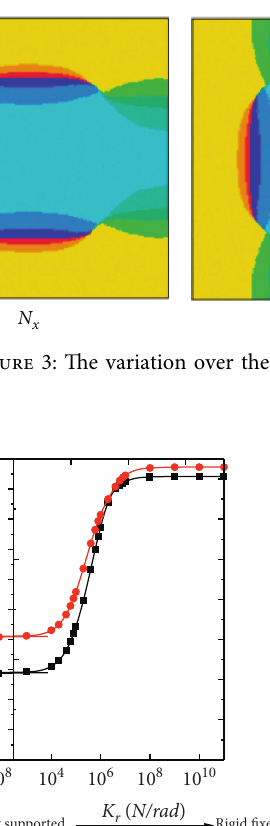
Figure 4: Effects of elastic boundary stiffnesses on the critical temperatures of composite laminated plates.